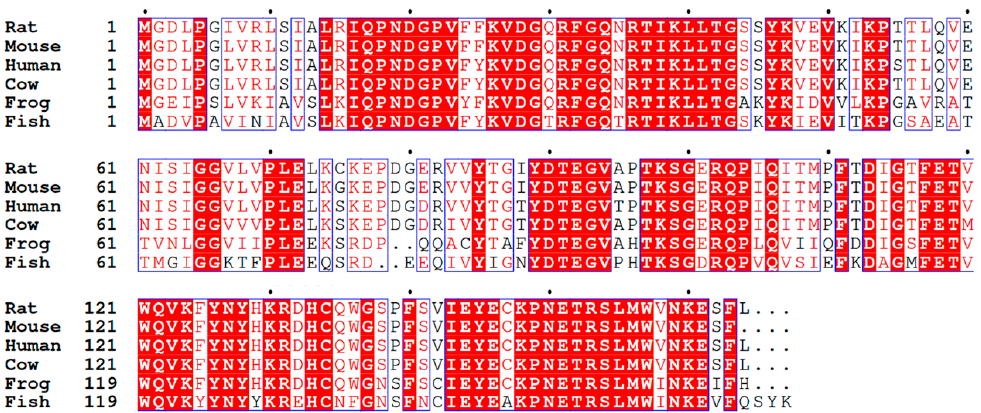
Figure 2. Primary sequence of CRIP1a from model organisms. Scientific names and protein codes: Rattus norvegicus (Q5M7A7), Mus musculus (Q5M8N0), Homo sapiens (Q96F85), Bos taurus (Q17QM9), Xenopus laevis (NP_001087998), Danio rerio (NP_001314699). The sequence identity relative to the top sequence proceeds down the alignment: 99%, 95%, 95%, 67%, and 59%.